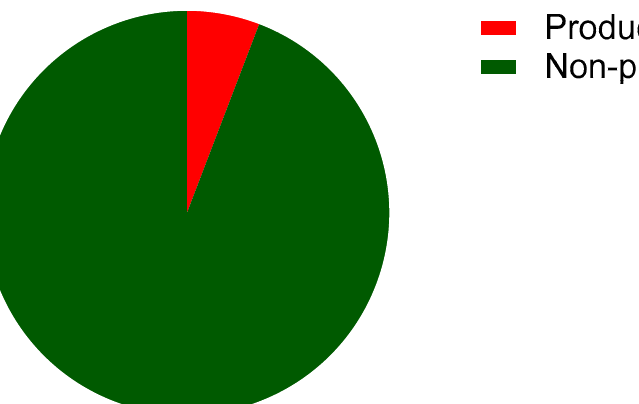
Figure 3. Proportion of ESBL producers among the enterobacterial strains isolated from urinary tract infections in Benin.